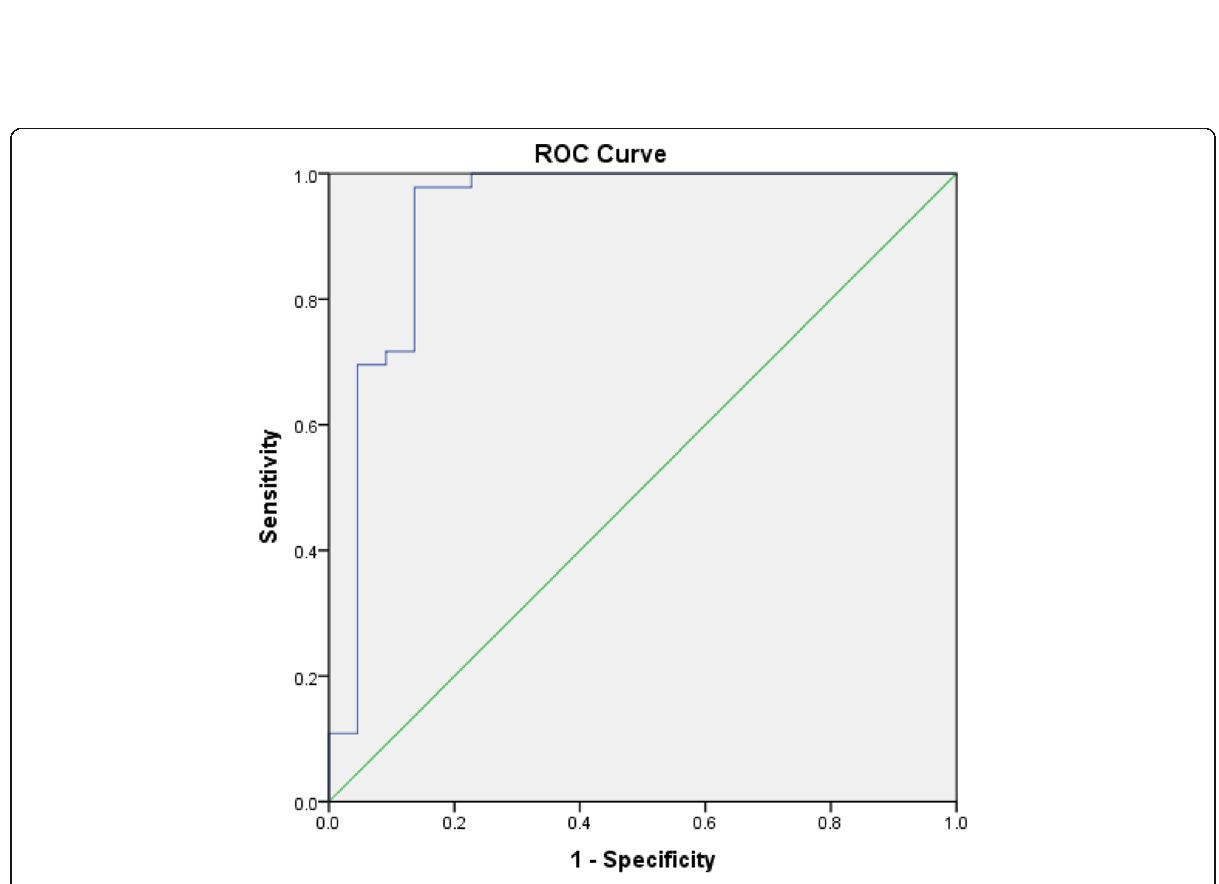
Fig. 3 ROC curve of serum S100A14 for discriminating between breast cancer group and healthy control